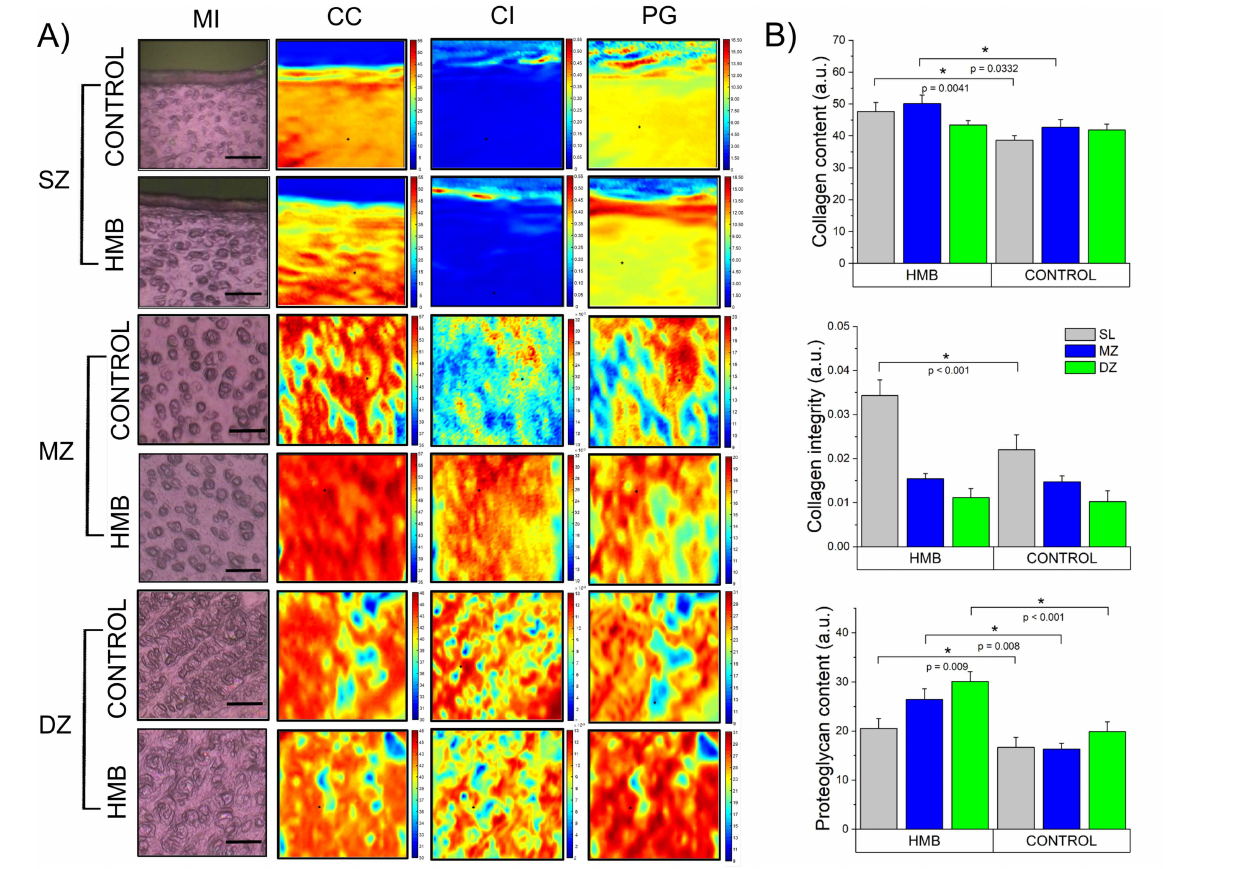
Figure 2. ( A ) The visible light microscopic images (MI) and representative chemical maps of porcine cartilage in three histological zones: superficial zone (SZ), middle zone (MZ) and deep zone (DZ), along with ( B ) the histograms of structural parameters characterizing articular cartilage: collagen content, collagen integrity and proteoglycans content with statistically significant differences between groups (at p < 0.05) marked with *. Chemical maps were constructed by integrating the area under the amide I band 1700 − 1600 cm − 1 (CC) as the ratio of the area of the CH 2 side chain of collagen 1360–1325 cm − 1 absorption to the amide II 1590–1490 cm − 1 (CI) and by integrating the area of the region assigned to the proteoglycans sugar ring 1140–965 cm − 1 (PG) in control and HMB-treated samples. The color scale indicates the pixel values for all parameters. These maps were typical of all samples. The scale bars correspond to 20 µ m. HMB—supplemented group, SZ—superficial zone, MZ—middle zone, DZ—deep zone, CC—collagen content, CI—collagen integrity, PG—proteoglycans